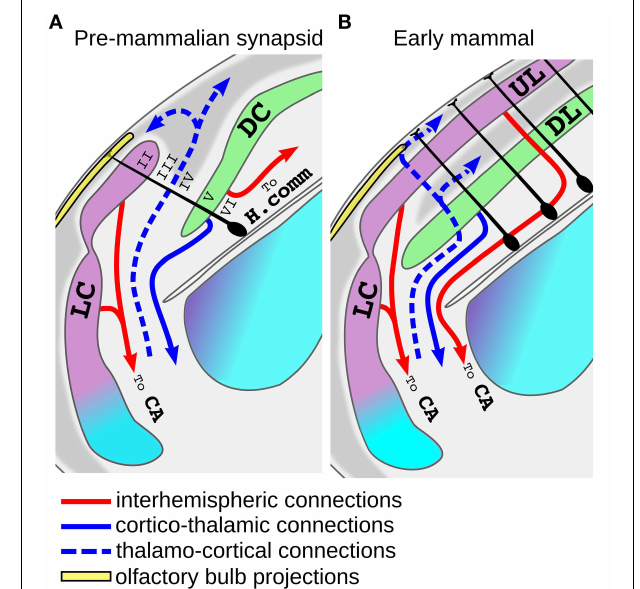
FIGURE 5 | Model for the origin of the neocortex from the superposition of lateral and dorsal cortex. (A) Schematic view of the putative organization of the dorso-lateral part of the telencephalon in an early mammaliaform (pre-mammlian synapsid). In these animals the lateral cortex (LC, violet) may have expanded over the dorsal cortex (DC, green), and at some point some radial glial progenitor (dark cells) may have started to produce both LC and DC cells. Note that since the internal anatomy of these animals is unknown, this scheme was based on modern macrosmatic reptiles. Radial glial cells of other brain regions are omitted for clarity. The proposed homology with neocortical layers is indicated with roman nueral. (B) Tangential expansion of the progenitors of the proto-neocortical column gave rise to the establishement of the neocortex. Note that the more lateral part of the neocortex maintains a direct olfactory input. Abbreviations: H.comm., hippocampal commissure; AC, Anterior